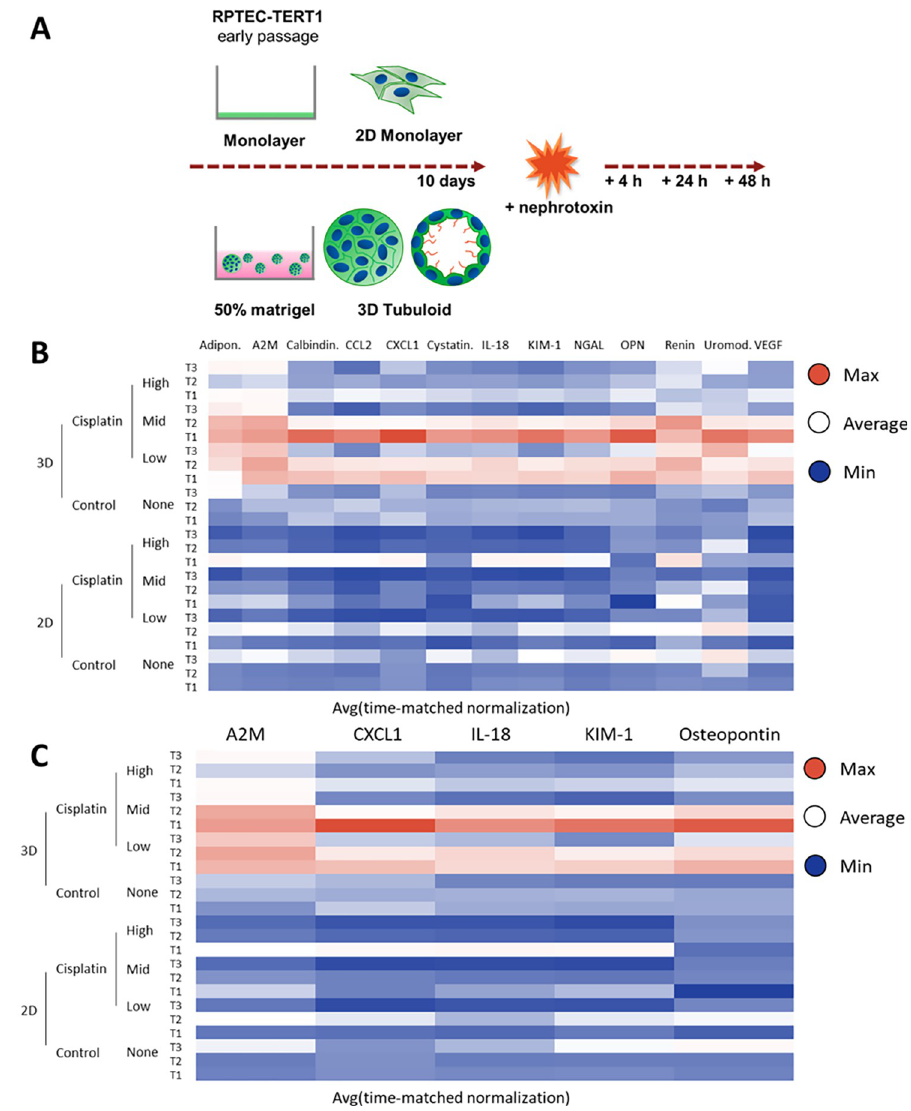
Fig 3. 96-well Luminex assay on cisplatin injured samples in 2D and 3D. (A) Injury assay design in 2D and 3D compares cells in monolayer to tubuloids following incubation with cisplatin at pre-determined timepoints. (B) All targets with signal from a 15-plex assay (2 targets, beta-2-microglobulin and TFF3, were not detected) with respect to 2D or 3D samples, and concentration of cisplatin, over time emphasized that 3D tubuloids had higher detectable proteins indicating injury from the 3D tubuloids than the 2D monolayer (C) The highest signal biomarkers were A2M, CXCL1, IL-18, KIM-1, and